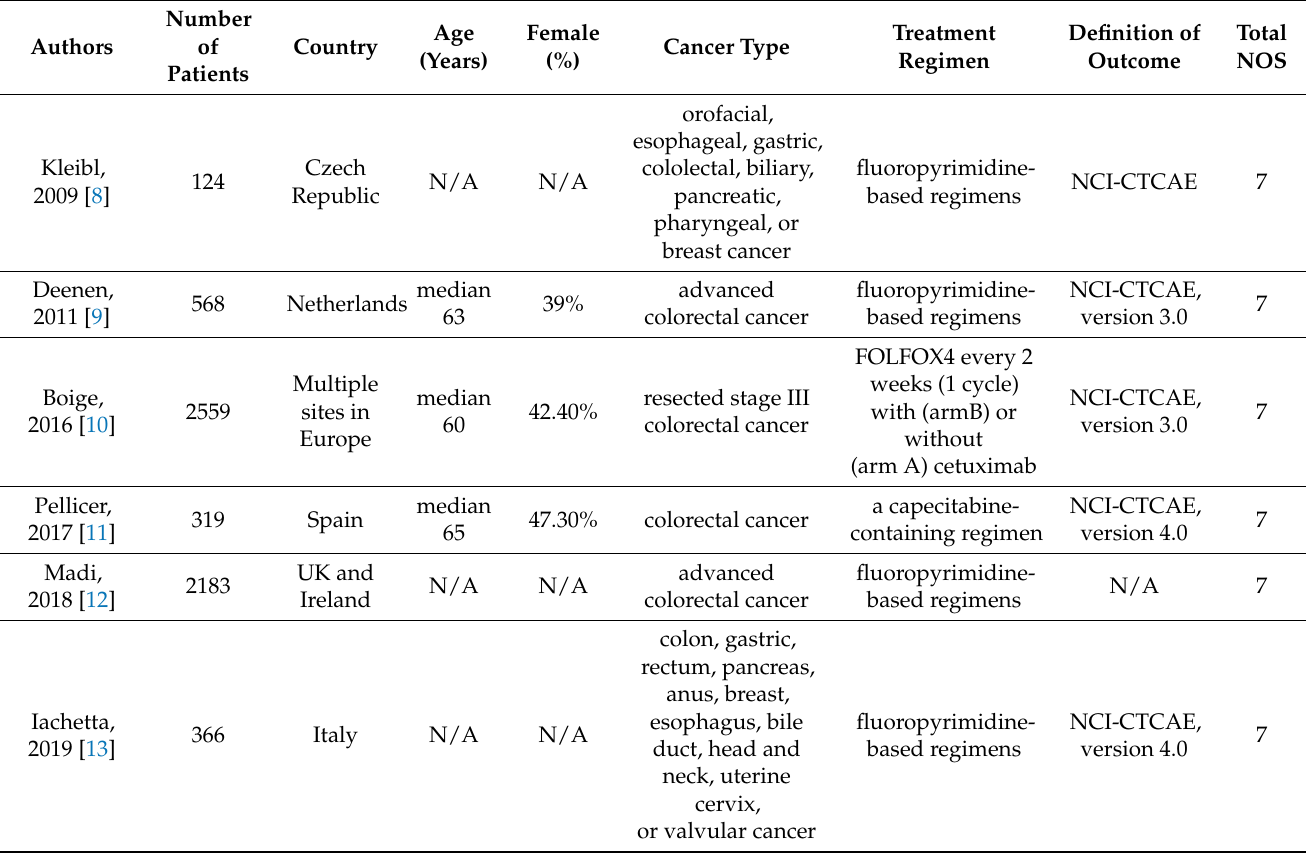
Table 1. Characteristics of studies